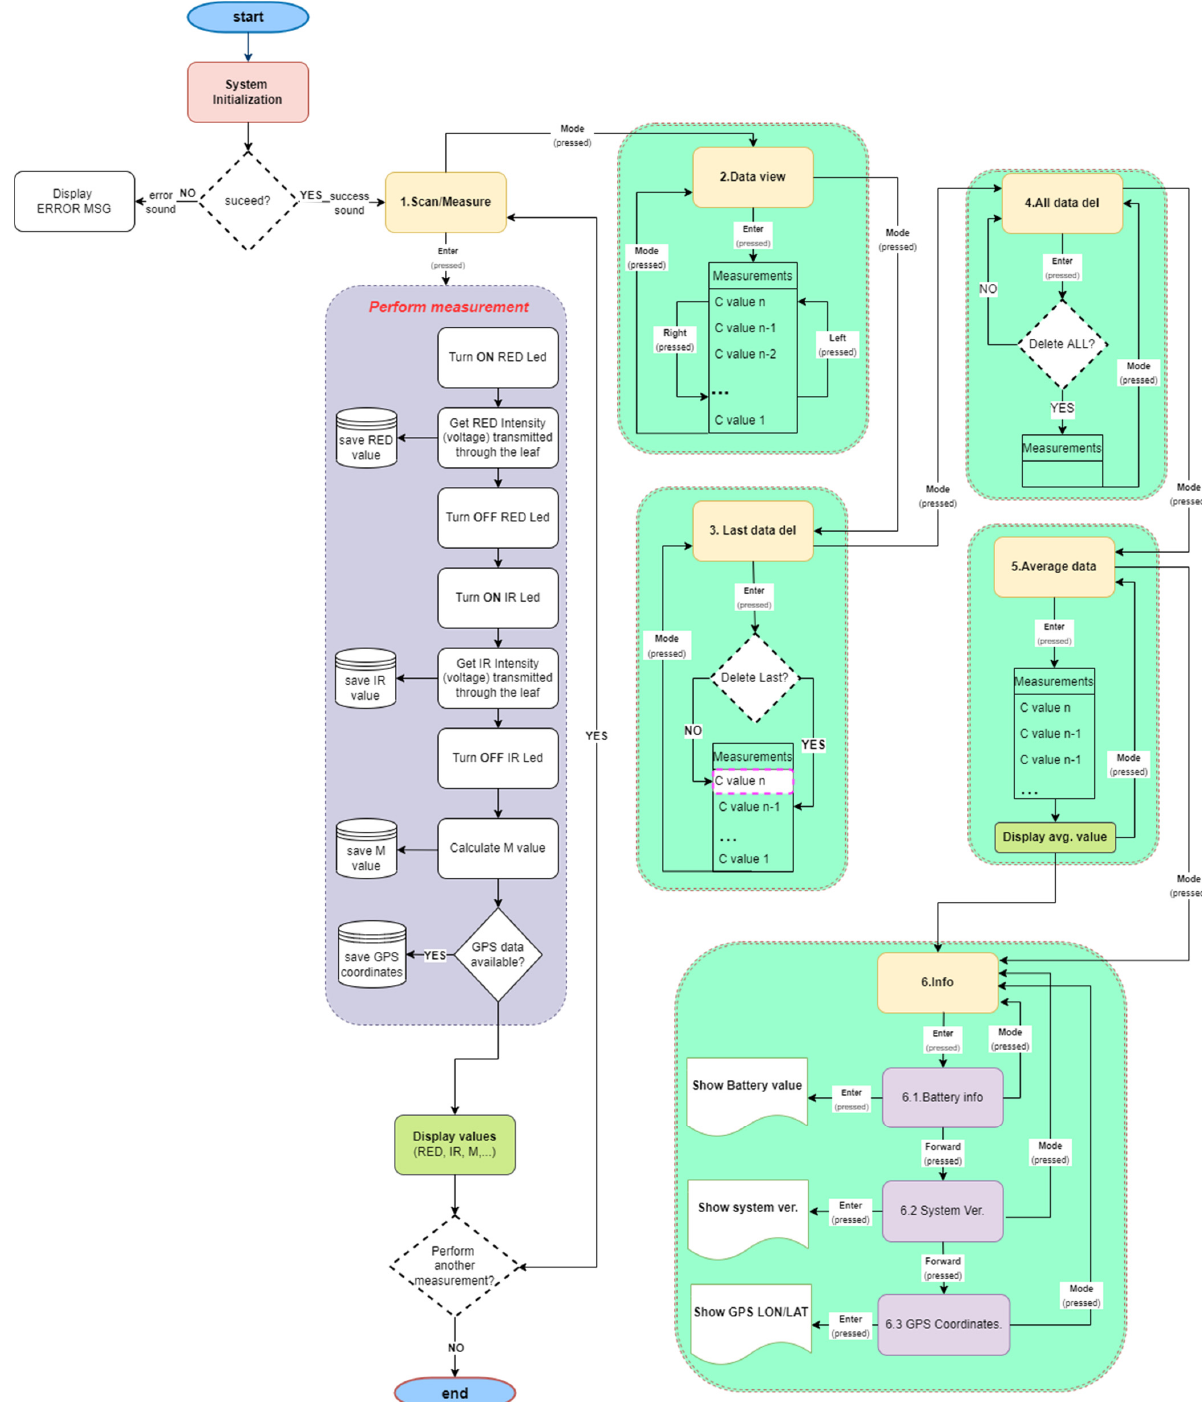
Figure 5. Flowchart of the proposed chlorophyll meter device software’s operation pipeline. The three buttons, named “mode”, “left”, and “right”, facilitate a user’s navigation through the menus that include data measurement view, last data, all data measurement deletion, data averaging, GPS coordinates, and battery life info display, etc. Audible sounds provided during the device’s operation facilitate the overall system’s use (e.g.,